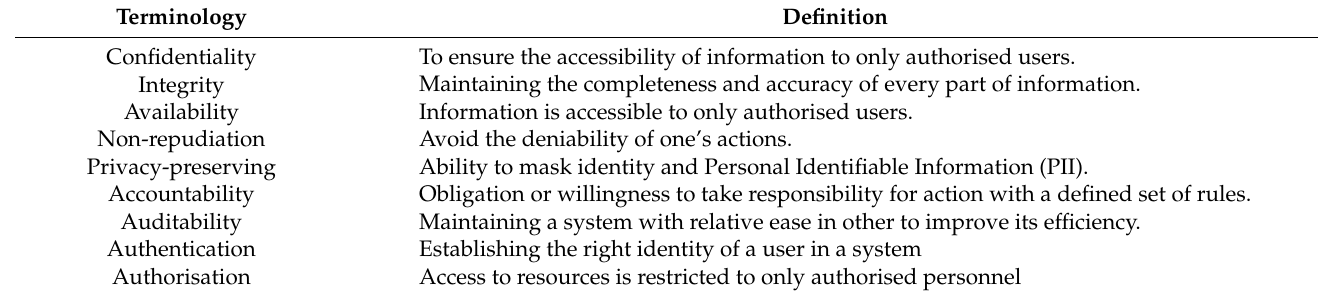
Table 1. Security parameter definition.